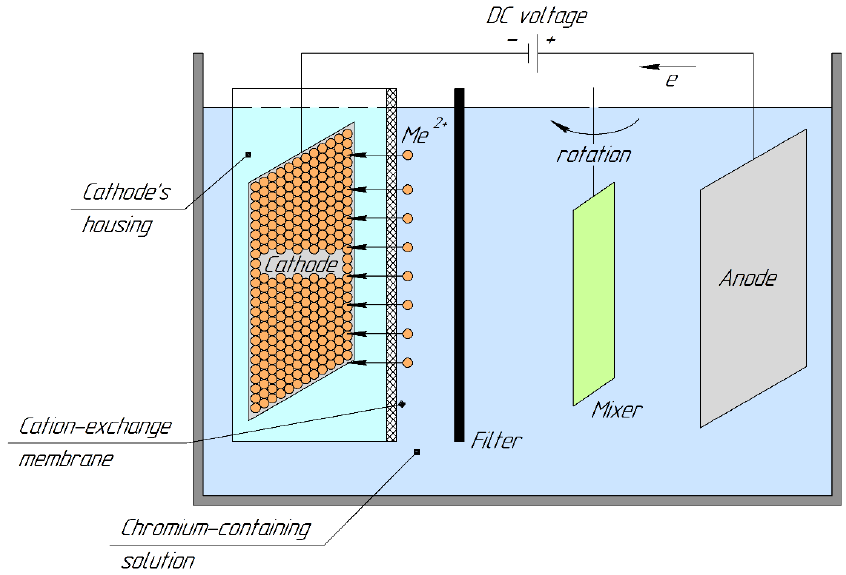
Figure 1. Design scheme of a membrane electrolyzer.